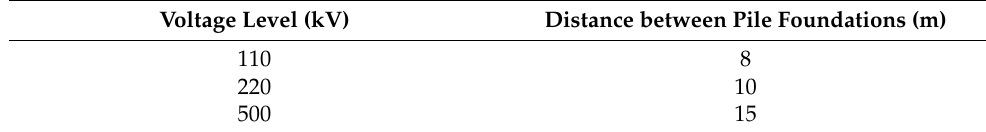
Table 7. Distance between pile foundations at each voltage level.